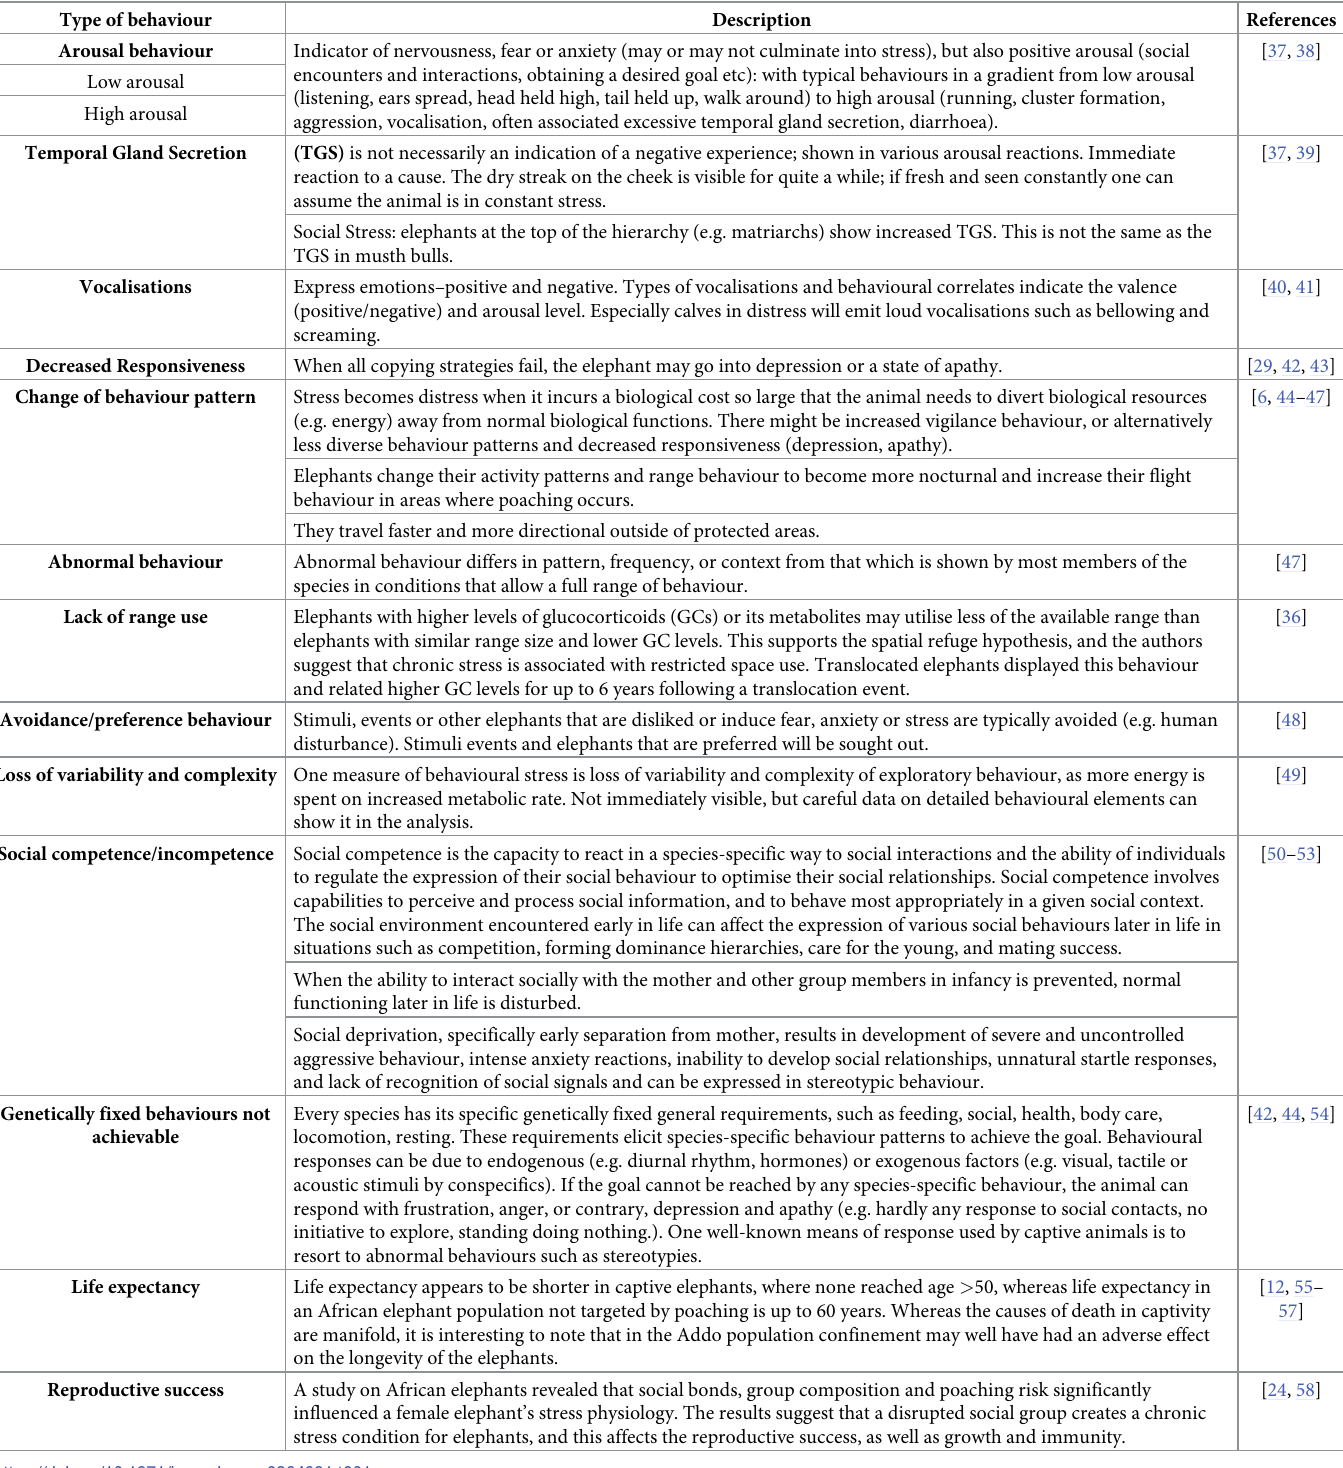
Table 1. The collation of potential elephant welfare parameters developed to date and applicable to free-ranging elephants. Type of behaviour Description Arousal behaviour Low arousal High arousal Temporal Gland